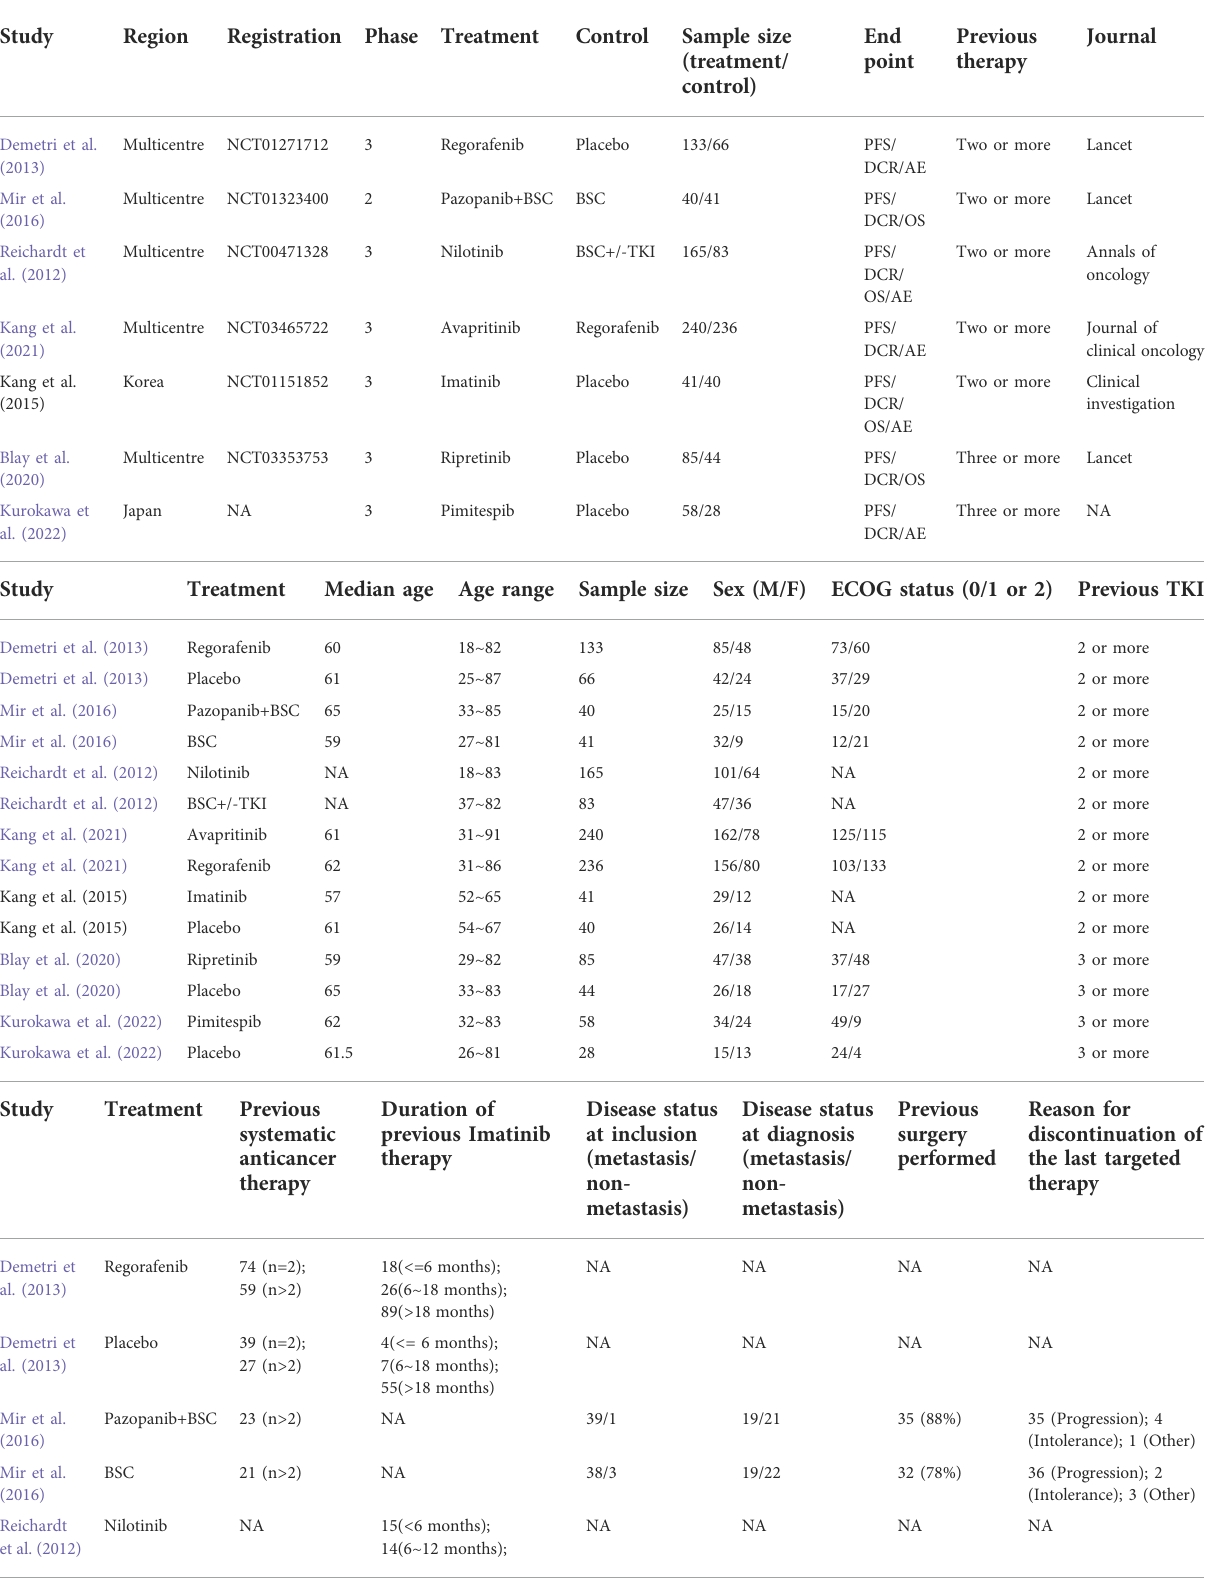
TABLE 1 Baseline characteristics of eligible studies in systematic